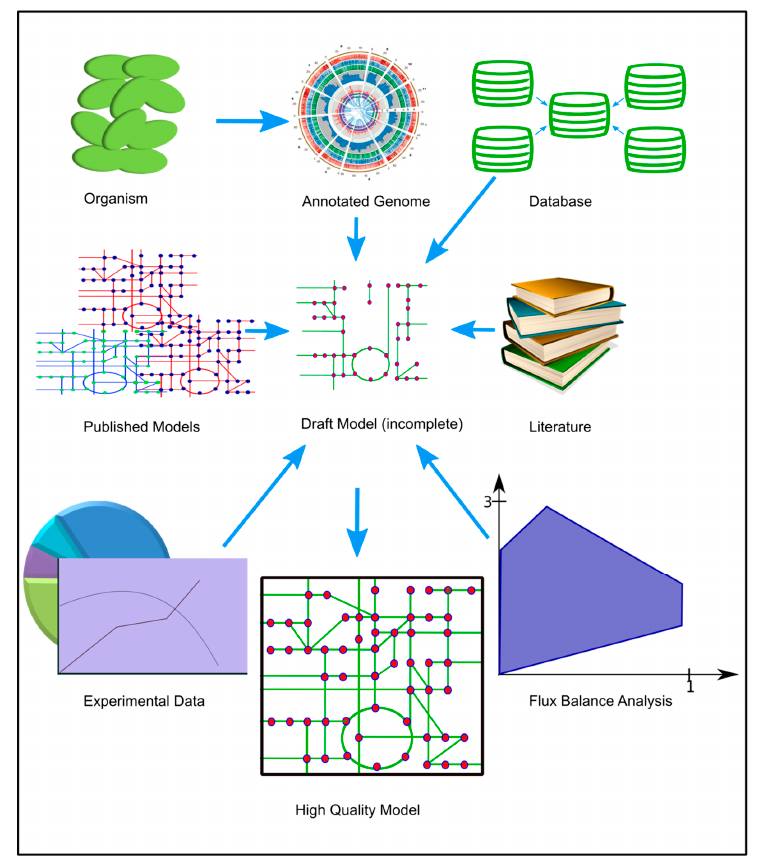
Figure 7. Diagram representing the steps to reconstruct metabolic models from its annotated genome. The genome of the organism was sequenced and annotated. A draft GSMM is obtained from the annotated genome. The draft model was refined iteratively using literature, biological database(s) and previously published models until a final curated model is obtained.